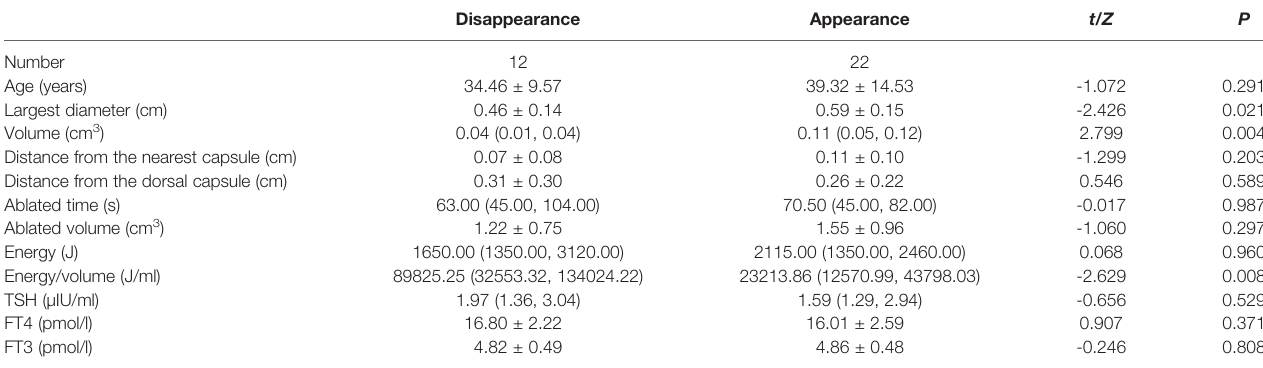
TABLE 2 | Comparison of characteristics between patients with and without complete remission at 12 months follow up.